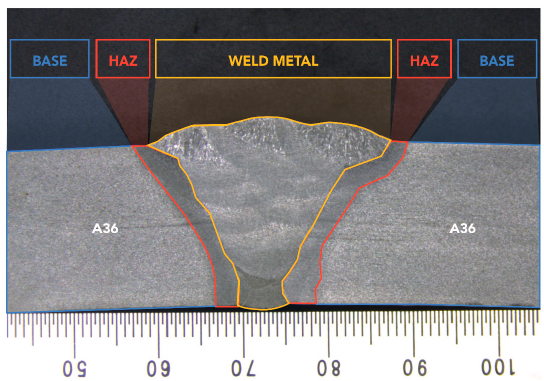
Figure 2. The illustration of the welded joint (base, HAZ, and weld metal zones).